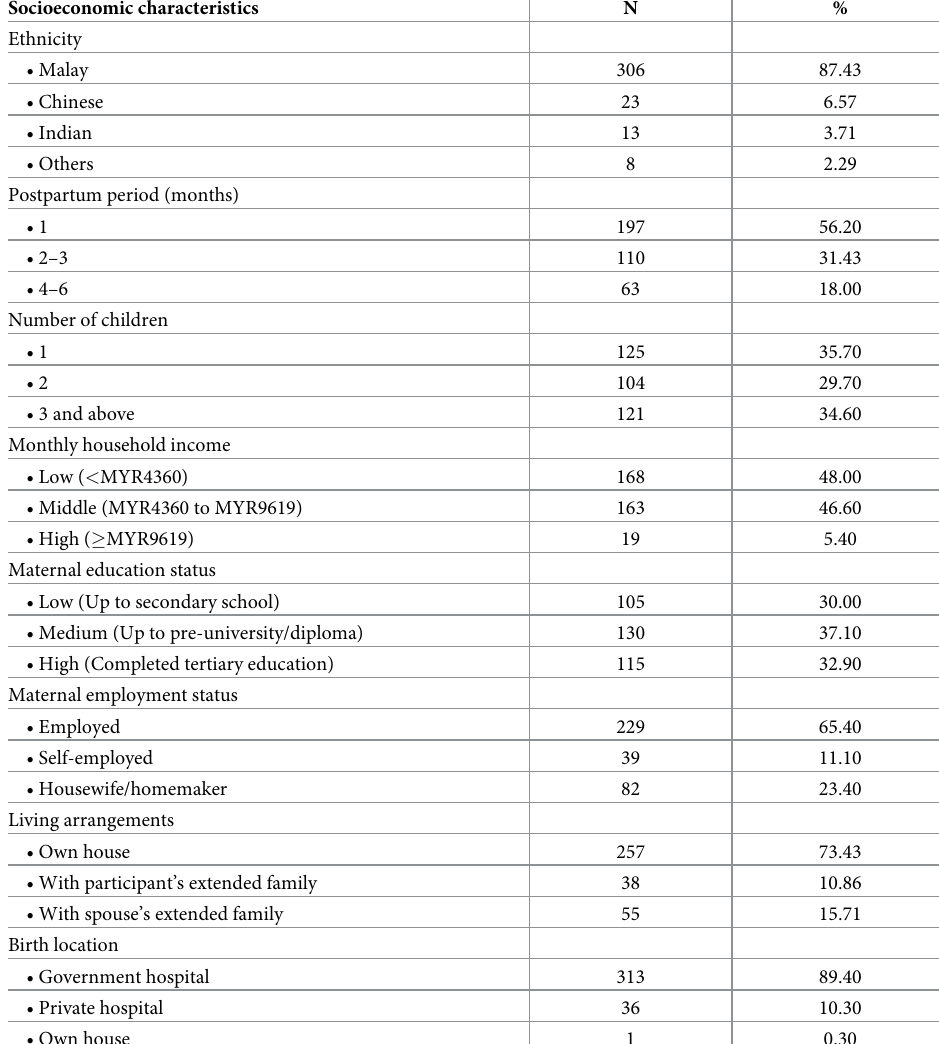
Table 1. Socioeconomic characteristics of the participants (N = 350) in this study. Socioeconomic characteristics